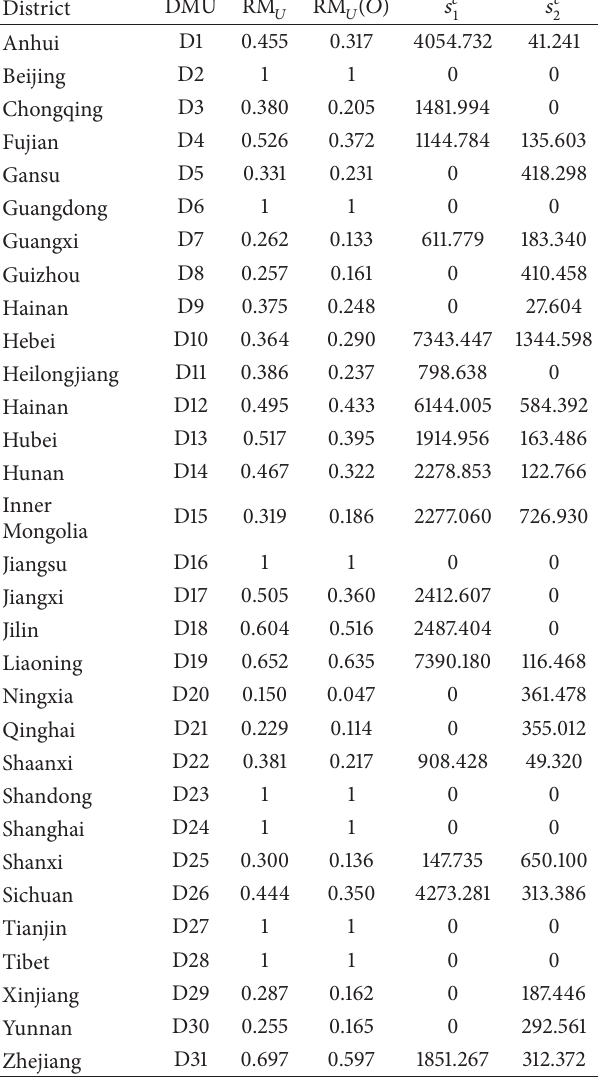
Table 2: Results of the proposed models.